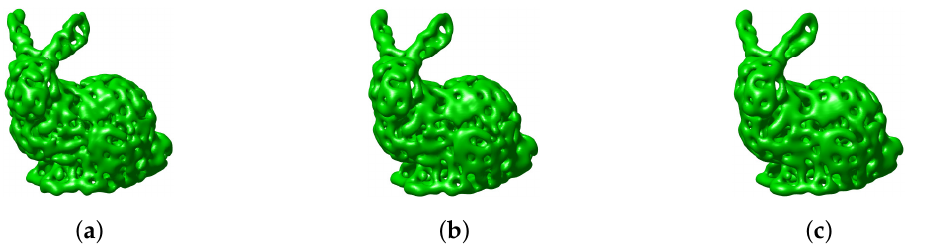
Figure 9. ( a – c ) are snapshots of phase separation with average concentration function Equation (13) on the Stanford Bunny at t = 40 ∆ t , 60 ∆ t , and 80 ∆ t , respectively.